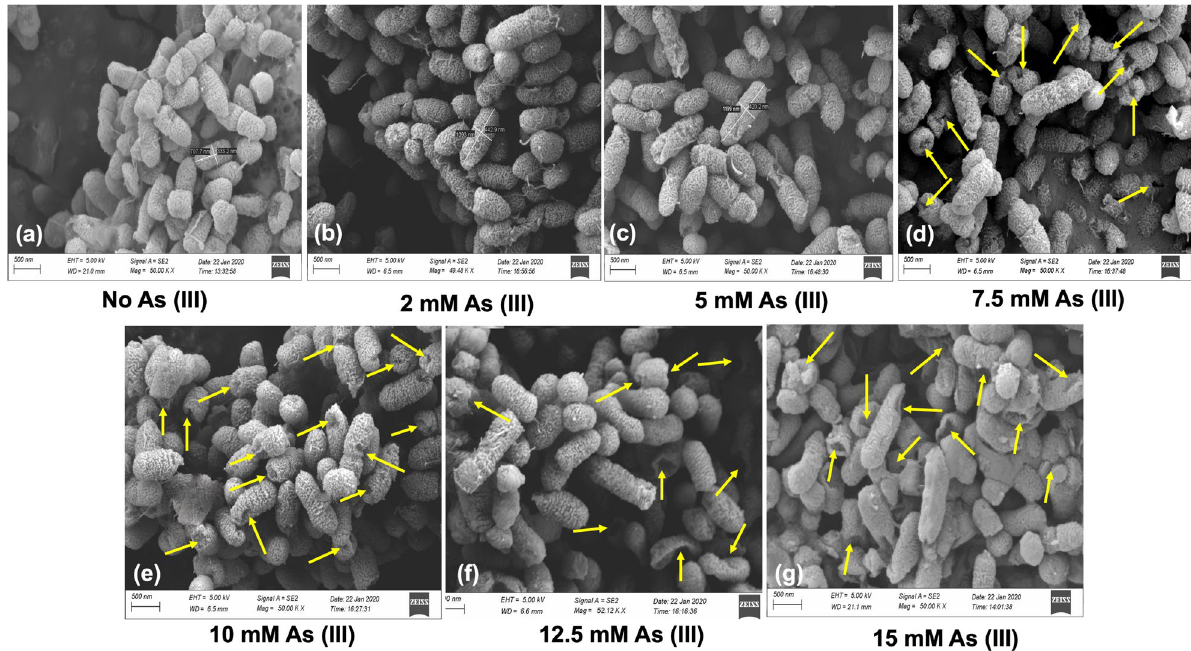
Figure 1. SEM micrographs of Achromobacter xylosoxidans BHW15. ( a ) Untreated BHW15 cells. The cell surface volume of BHW15 increased after treatment with 2 mM ( b ) and 5 mM As (III) ( c ). After treatment